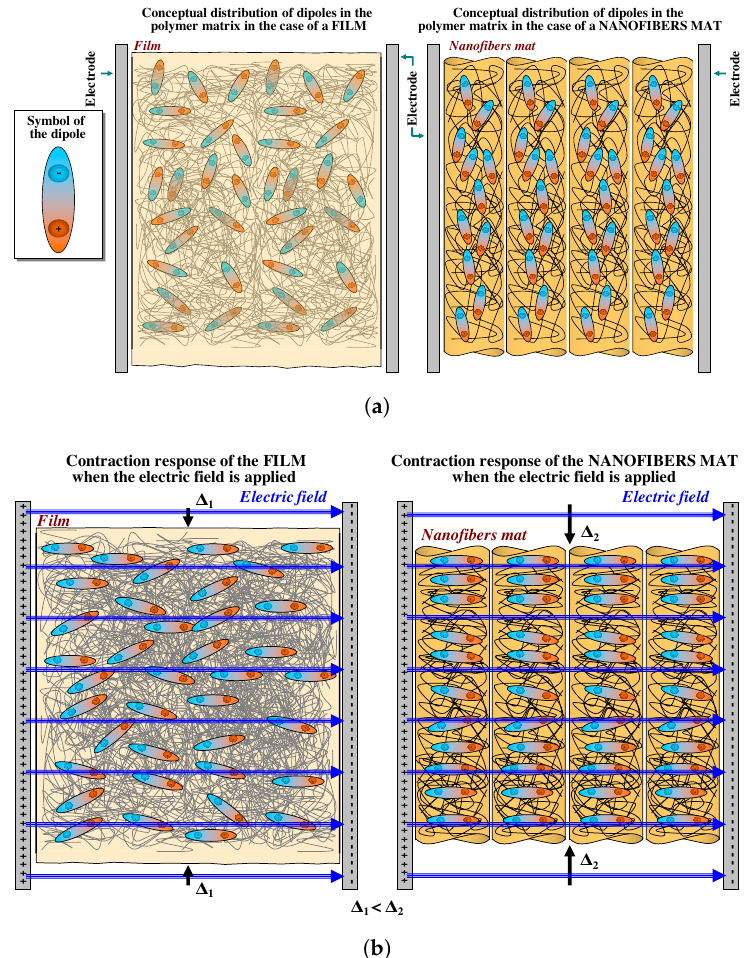
Figure 10. Schematic representation of a film and a nanofibers mat. ( a ) Randomly oriented dipoles in the film and in the nanofibers mat without any applied electric field. ( b ) When an electric field is applied, the dipoles are oriented according to the electric field, and therefore both specimens contract. The nanofibers shows a larger contraction ∆ 2 when compared to the contraction ∆ 1 < ∆ 2 of the film.